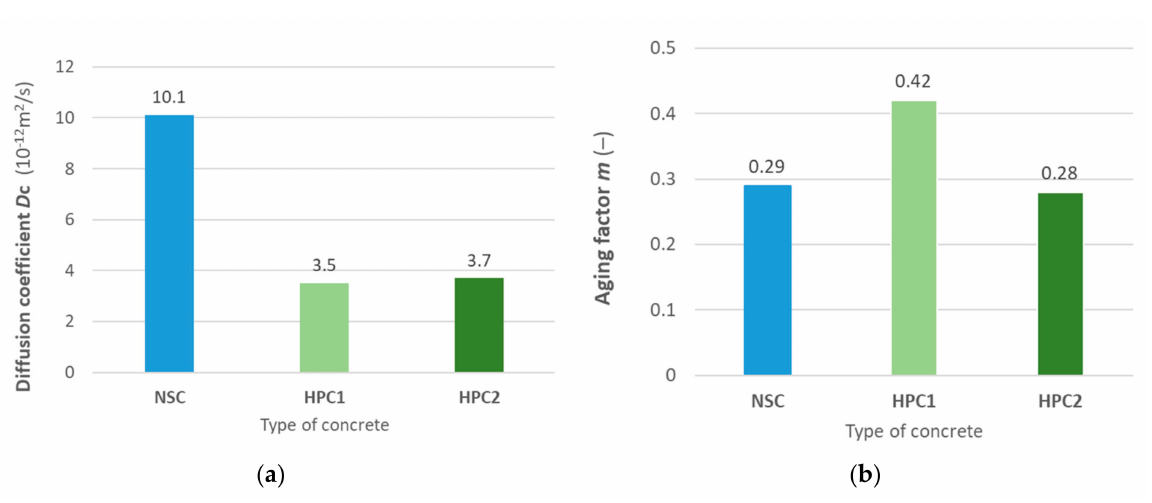
Figure 5. Comparison of aging factor ( a ) and diffusion coefficient ( b )—NSC and